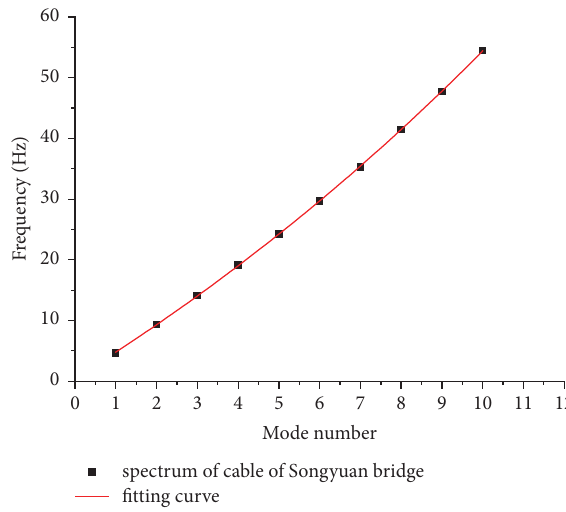
Figure 23: Spectrum fitting of cables in the Songyuan Bridge.